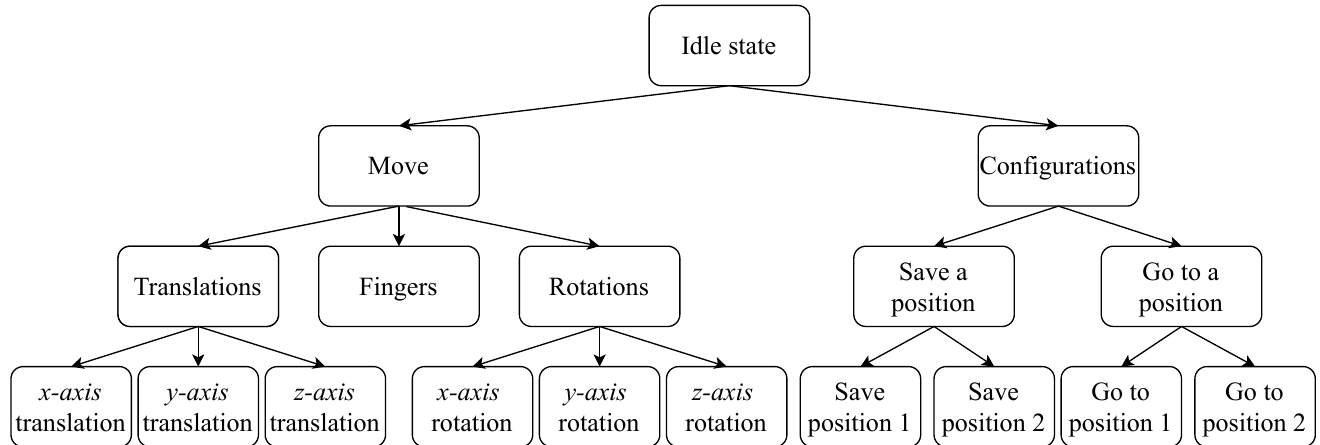
Figure 1. Graph of possible sub-control groups for an assistive robotic